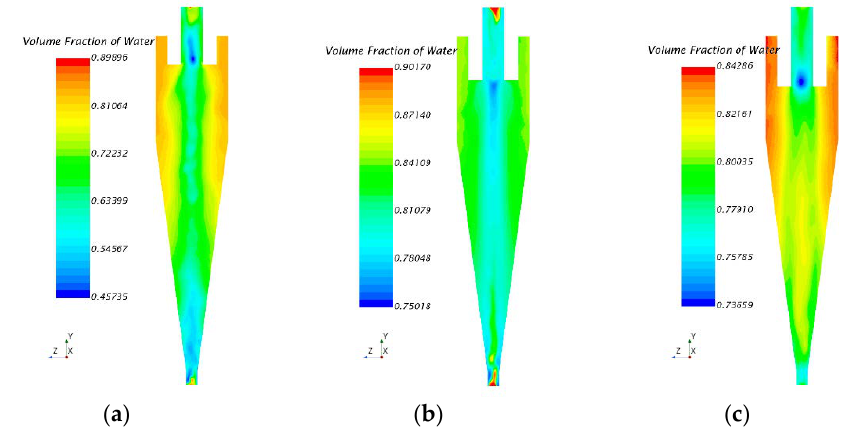
Figure 6. Volume fraction of water at 60 s at an inlet feed velocity of 10 m/s ( a ) VF = 20 mm ( b ) VF= 30 mm ( c ) VF = 35 mm. ( b ) VF = 30 mm ( c ) VF = 35